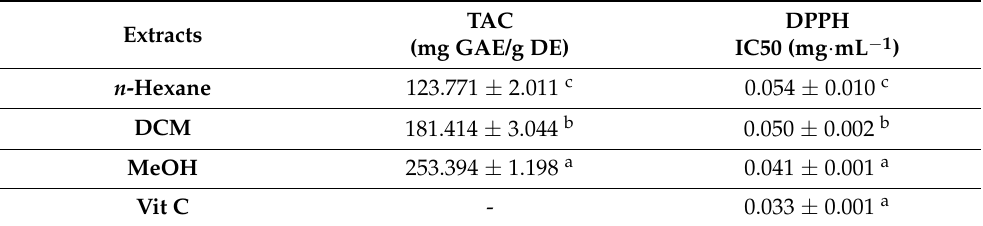
Table 4. Total antioxidant capacity and DPPH scavenging activity of different extracts of C. aegyptiaca fruits.